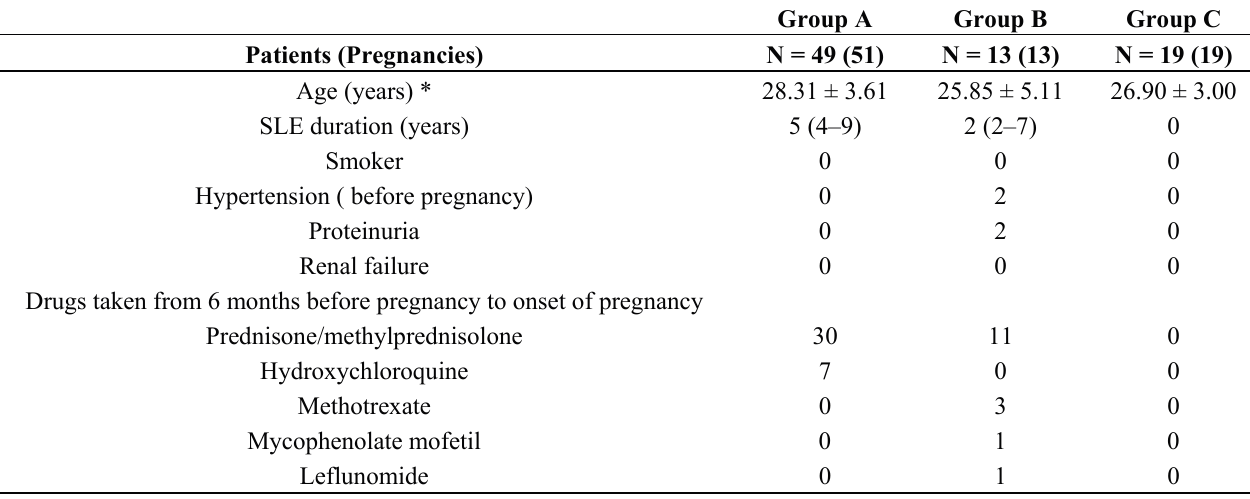
Table 1. Baseline characteristics of pregnant women with SLE before